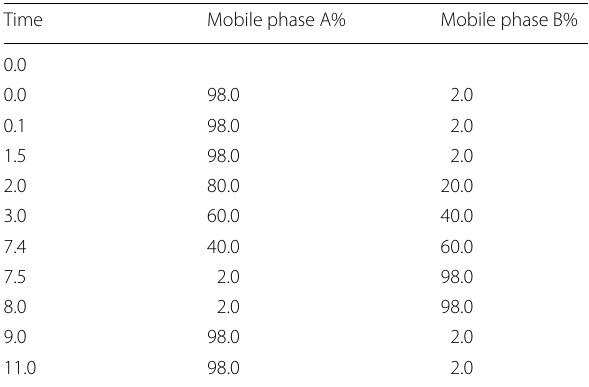
Table 1 Gradient elution program during the chromatographic